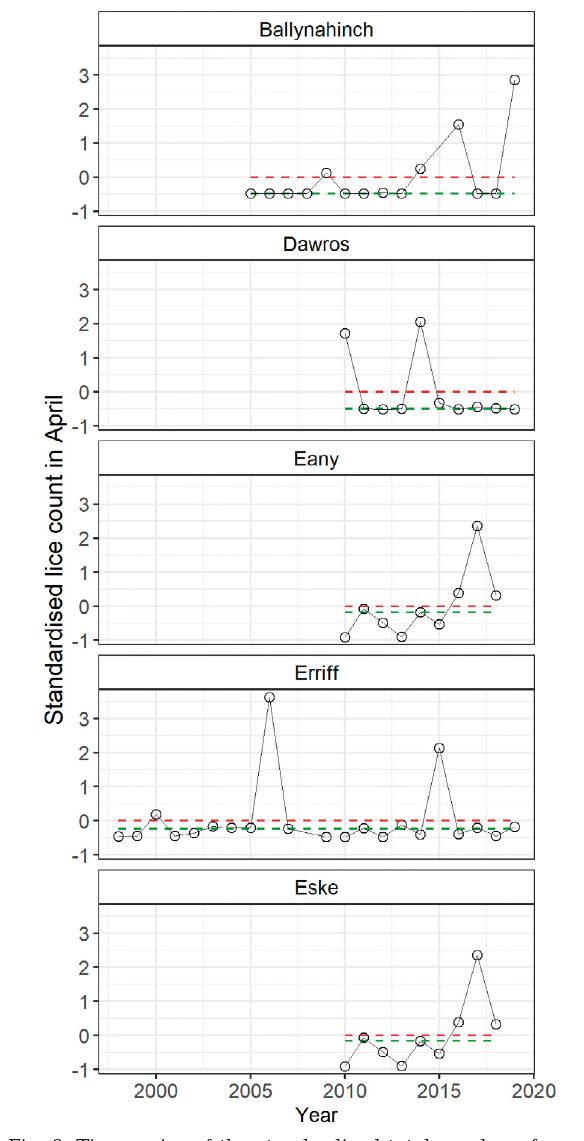
Fig. 2. Time series of the standardised total number of mo- bile lice counted on the salmon farms nearest to study rivers in April (open circles). Note that this provides the same se- ries for the Eany and Eske rivers, which have the same near- est salmon farm site (F4; see Fig. 1). Red dashed line is the average louse pressure value for each system; green is